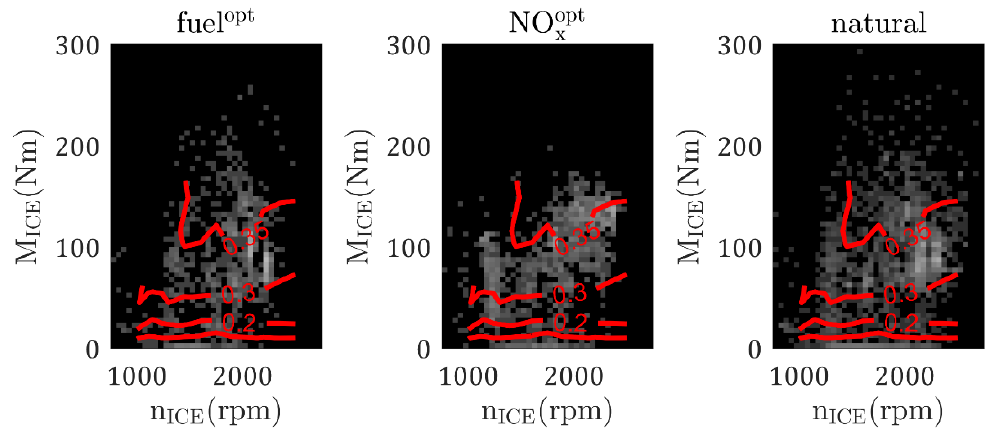
Figure 10. Distribution of engine operating conditions in the engine efficiency map for the fuel optimal driving cycle ( left ), NOx optimal driving cycle ( center ) and natural driving ( right ). The color-scale represents the frequency of the operating conditions in the tested cycle from white (high frequency) to black (low frequency).